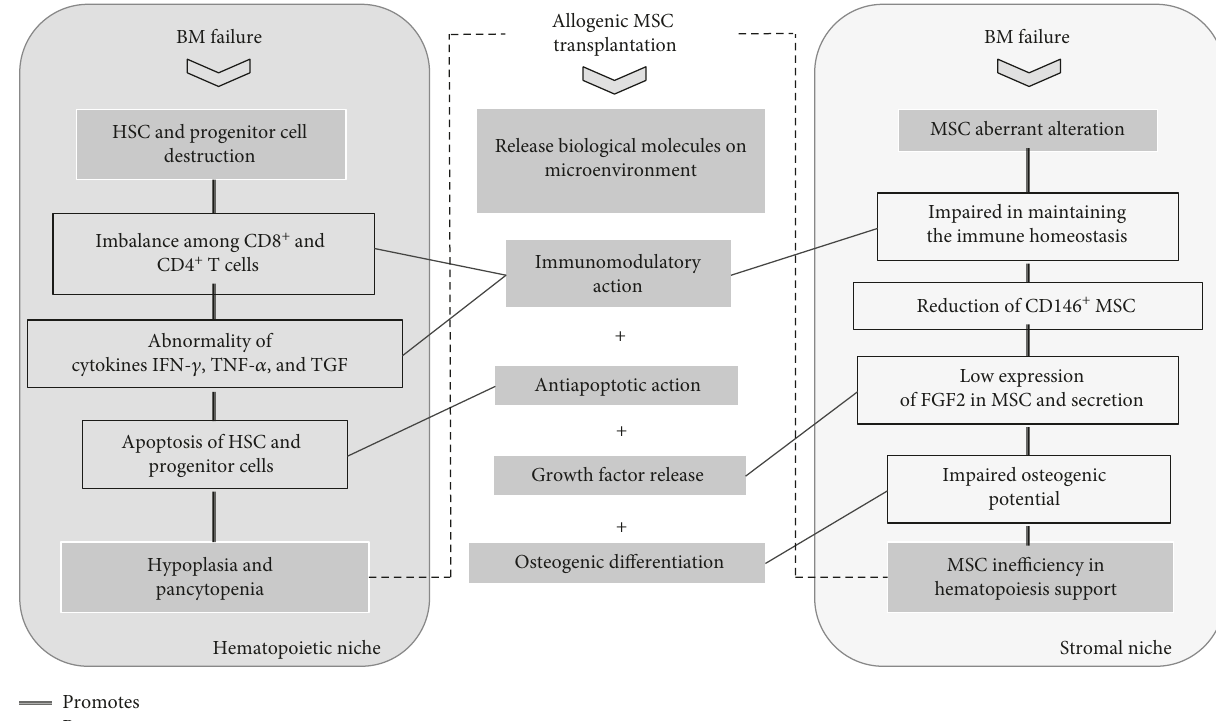
Figure 1: E ff ect of mesenchymal stem cell (MSC) transplant on bone marrow failure (BMF) etiology and progression. Acquired aplastic anemia (AA) is caused by destruction of hematopoietic stem cell (HSC) and progenitor cells associated with MSC abnormalities, caused by hematotoxic agents (drugs, chemical agents, radiation, and virus). These events lead to imbalance among CD8 + and CD4 + T cells and abnormal cytokine secretion, which correlates apoptosis of HSC and progenitor cells and consequently bone marrow (BM) aplasia and pancytopenia. Additionally, in turn of BM, imbalance aberrant alteration on MSC from BM niches arises. MSC aberrant alteration is observed by, impaired in maintaining the immune homeostasis, reduction of CD146 + MSC and low expression of FGF2 in MSC and its secretion, which lead to MSC ine ffi ciency in hematopoiesis support and collaborate to progress of disease. According to the literature for AA, MSCs improve engraftment of HSC and prevent apoptosis in BM failures. BMF improvements occur as a result of MSC transplant through very similar mechanisms, such as immunomodulation, release growth factors, and osteogenic support. Although in vivo improvement on hematopoiesis was not demonstrated, several properties of MSCs, as well as its association with AA, justify the use of MSC in BM